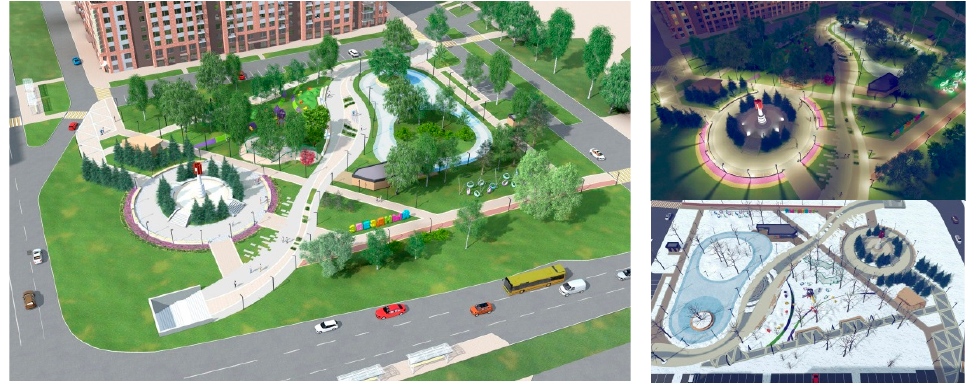
Figure 12. Improvement of a residential yard in Izhevsk (project) (http://tehne.com/event/novosti/vse-proekty-konkursa-koncepciy-blagoustroystva-territorii-prilegayushchey-k-mfk-rivera-zhk-no1-v-izhevske/ (accessed on 8 June 2022)).